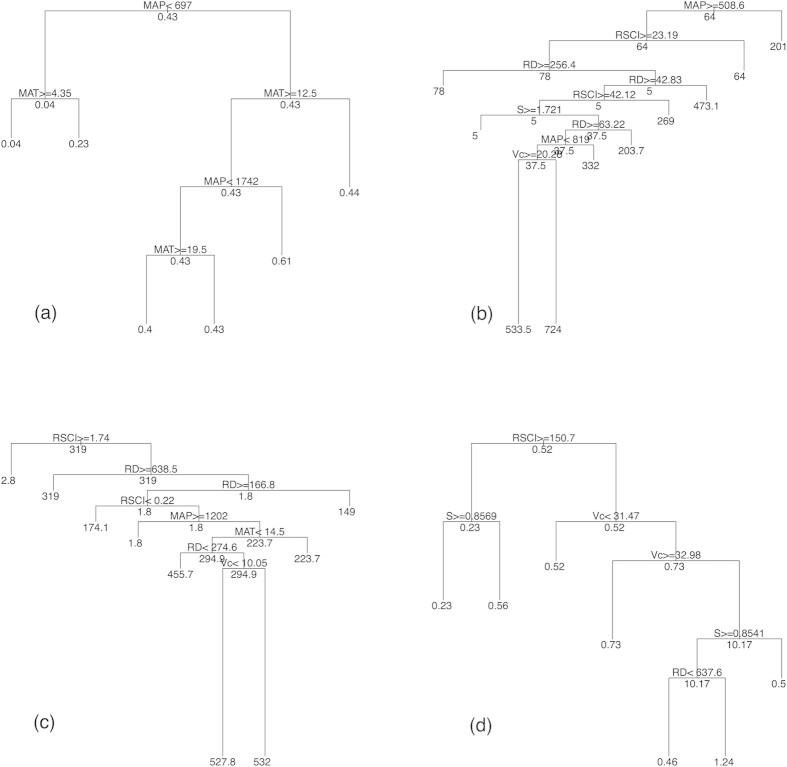
CART based regression tree of environmental variables.Splits are determined by their contribution to the overall model and reduce predictive error. The longer the branches in the tree, the greater the deviance explained. (a) Rc as response variable; (b) TSSC as response variable; (c) TSSL as response variable; (d) TOCL as response variable. Abbreviations of the variables as shows in Table 1.